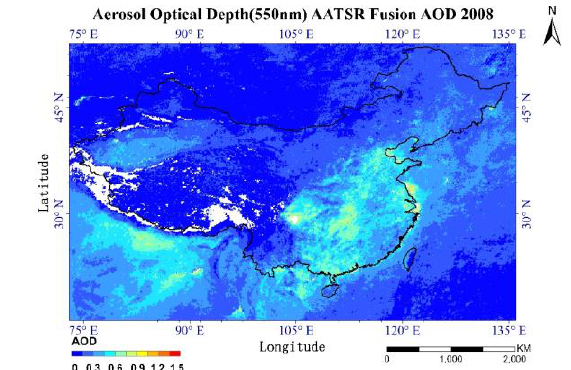
Figure 3. Annual average of fused AOD (550 nm) distributions over China in